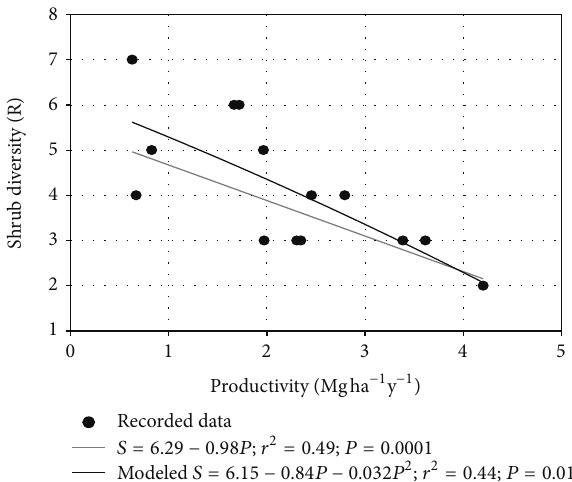
Figure 5: The relationships between measured and modeled shrub species richness for late successional stages and measured above- ground biomass productivity for the Tamaulipan thornscrub forests of northeastern